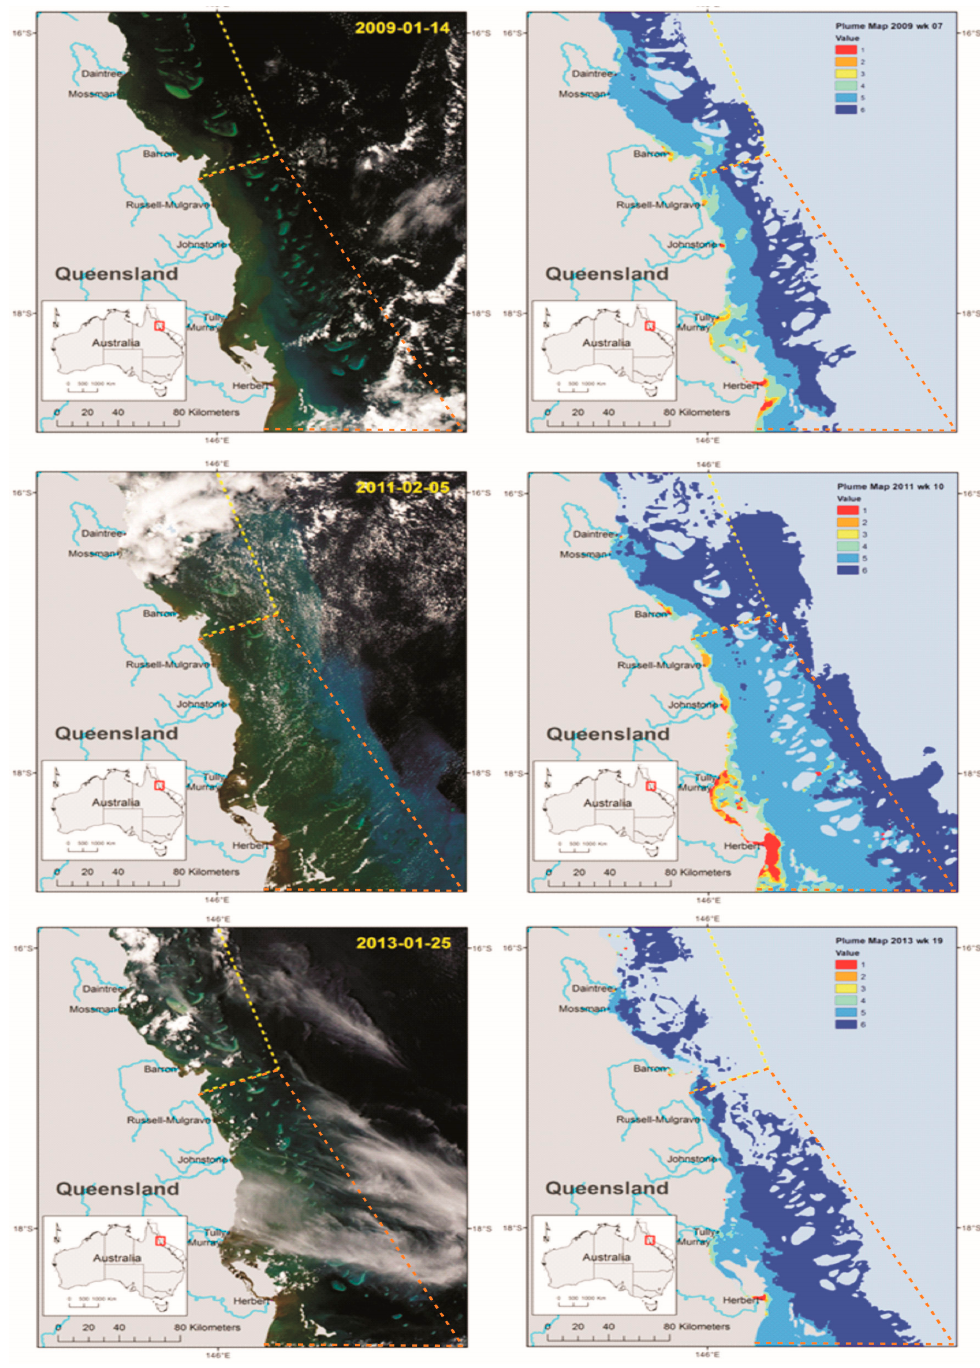
Figure 3. Selected satellite images showing plume water intrusion into the CoTS initiation zone (south) and the region south to the Palm Island Group over three years (left column) and the corresponding weekly plume colour class map (right column). Dashed yellow lines on maps stand for the south delimitation of the CoTS initiation zone and the secondary outbreak zone is shown by the red dashed lines. Plume colour classes vary from one to six, as described in the text. The stage of river discharge on each occasion is shown in Figure 2.